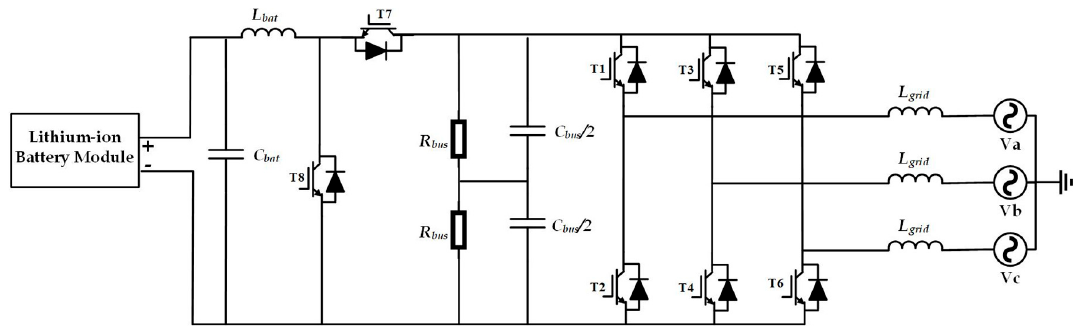
Figure 17. Simulink model of the FB and the Two-Quadrant converter for Heavy-Duty Vehicles. Table 9. Main characteristics of the Light-Duty system connected to LV Batteries.